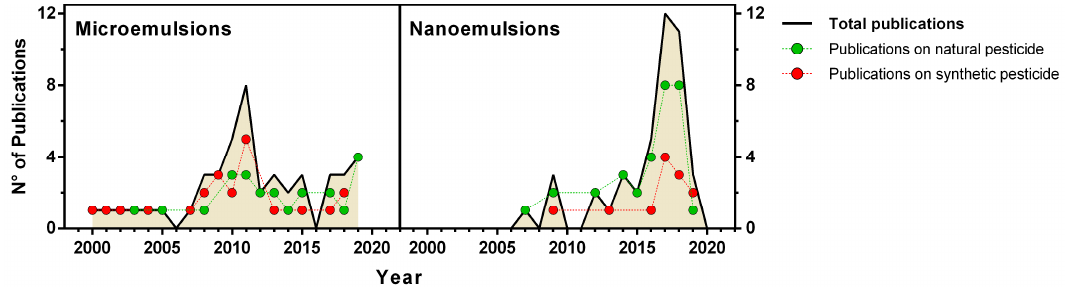
Figure 3. Number of publications on micro-(left) and nanoemulsion (right) vehicles for natural and synthetic pesticides per year.